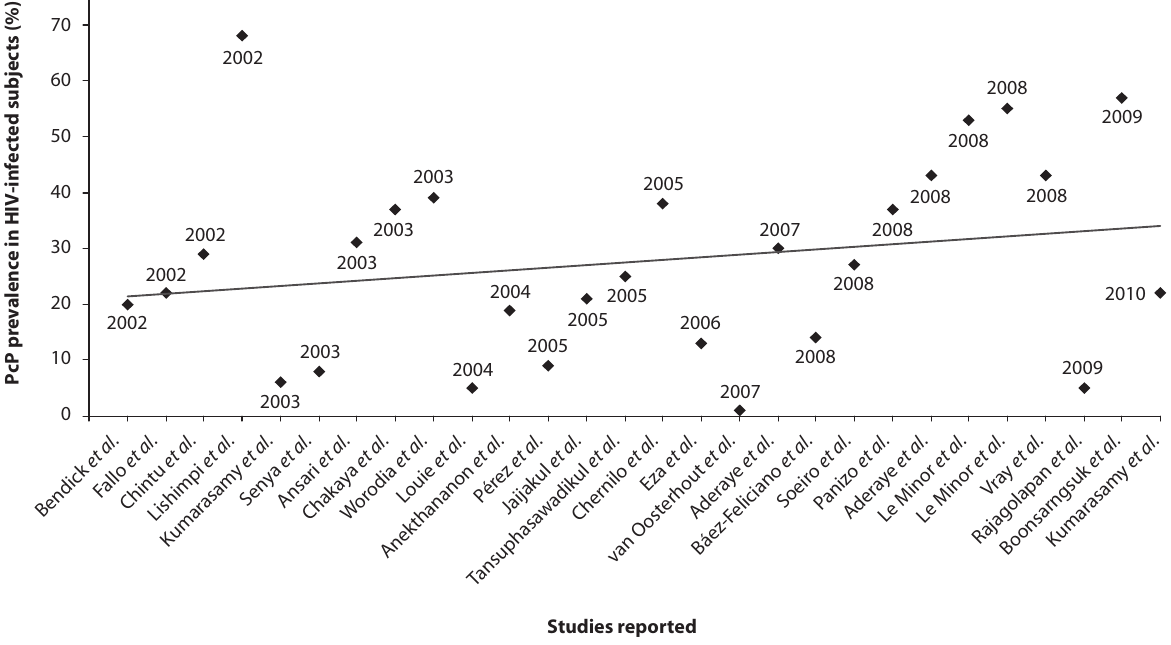
Fig 1. – Pneumocystis jirovecii pneumonia (PcP) rates among HIV-infected subjects in developing countries from 2002 until